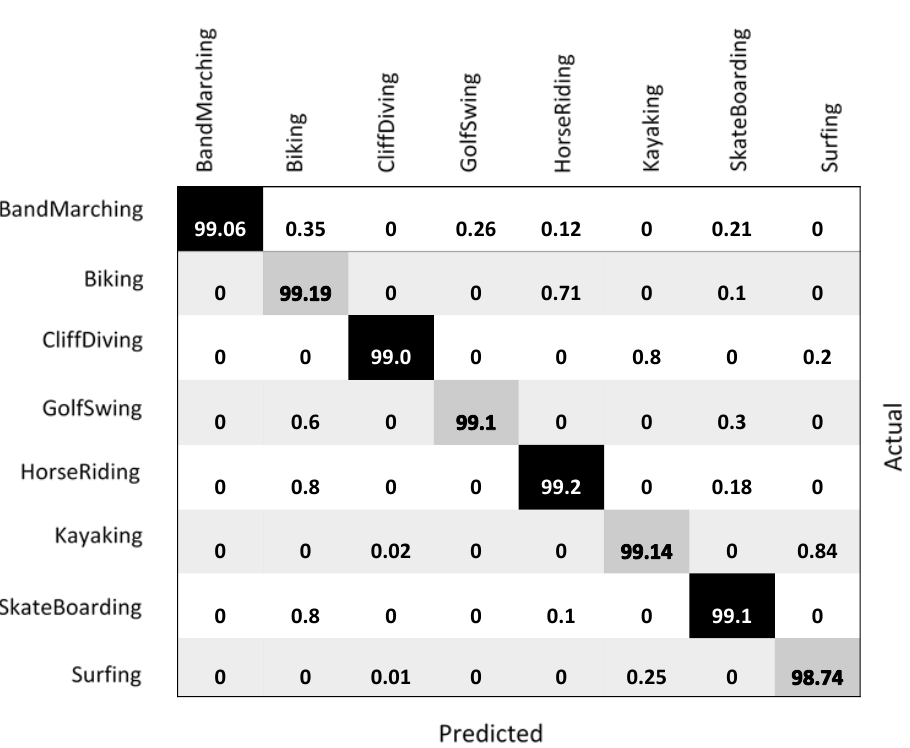
Figure 13. Classification results evaluated from testing the proposed model on the YouTube-Aerial dataset as a confusion matrix. Each cell gives the accuracy for each class measure in